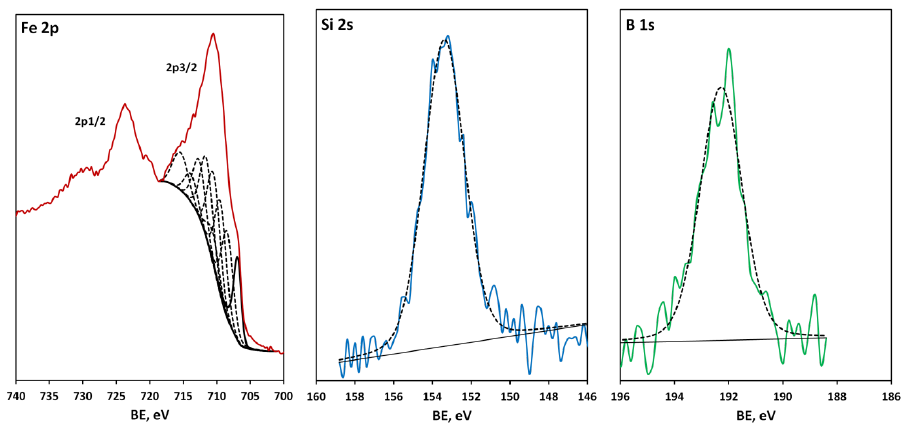
Figure 2. (Color online) Fe 2p, Si 2s and B 1s spectra of a metglas-on-silicon sample produced at the first stage of the technology improvement. Experimental spectra (solid colour lines) were fitted using the bands which are depicted by black dashed lines, save the band at 706.7 eV assigned to metallic iron, highlighted with a solid black line.